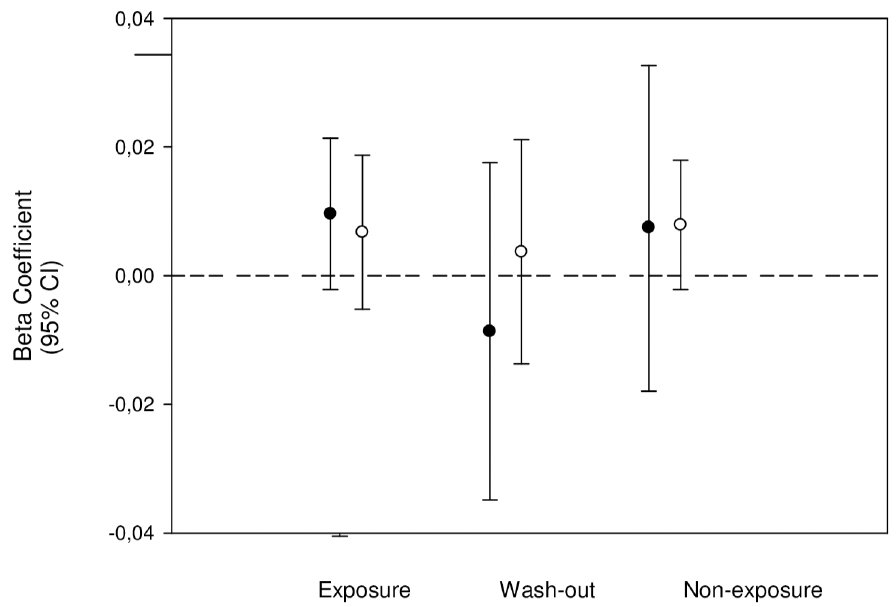
Fig 2. The slopes (95% CI) for linear change in T1D risk among individuals with various gestational exposures to margarine fortification. The slopes, or beta regression coefficients, are expressed in log HR per month of birth; in black — adjusted for sex, in white — adjusted for sex and cumulative gestational sunshine.